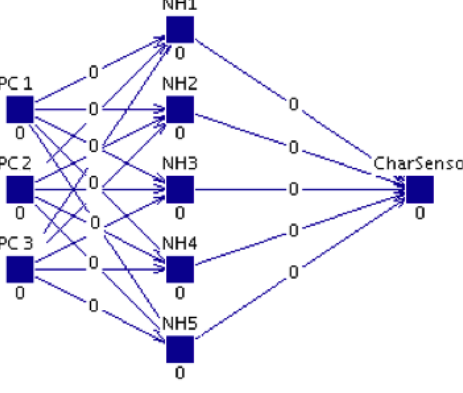
Figure 5. Schematic representation of neural model for the